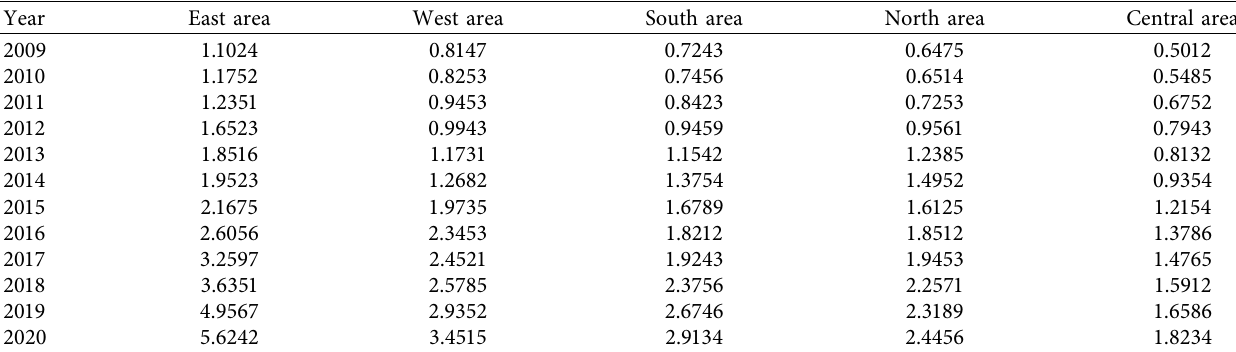
Table 4: FtSE values obtained by SEDEA.